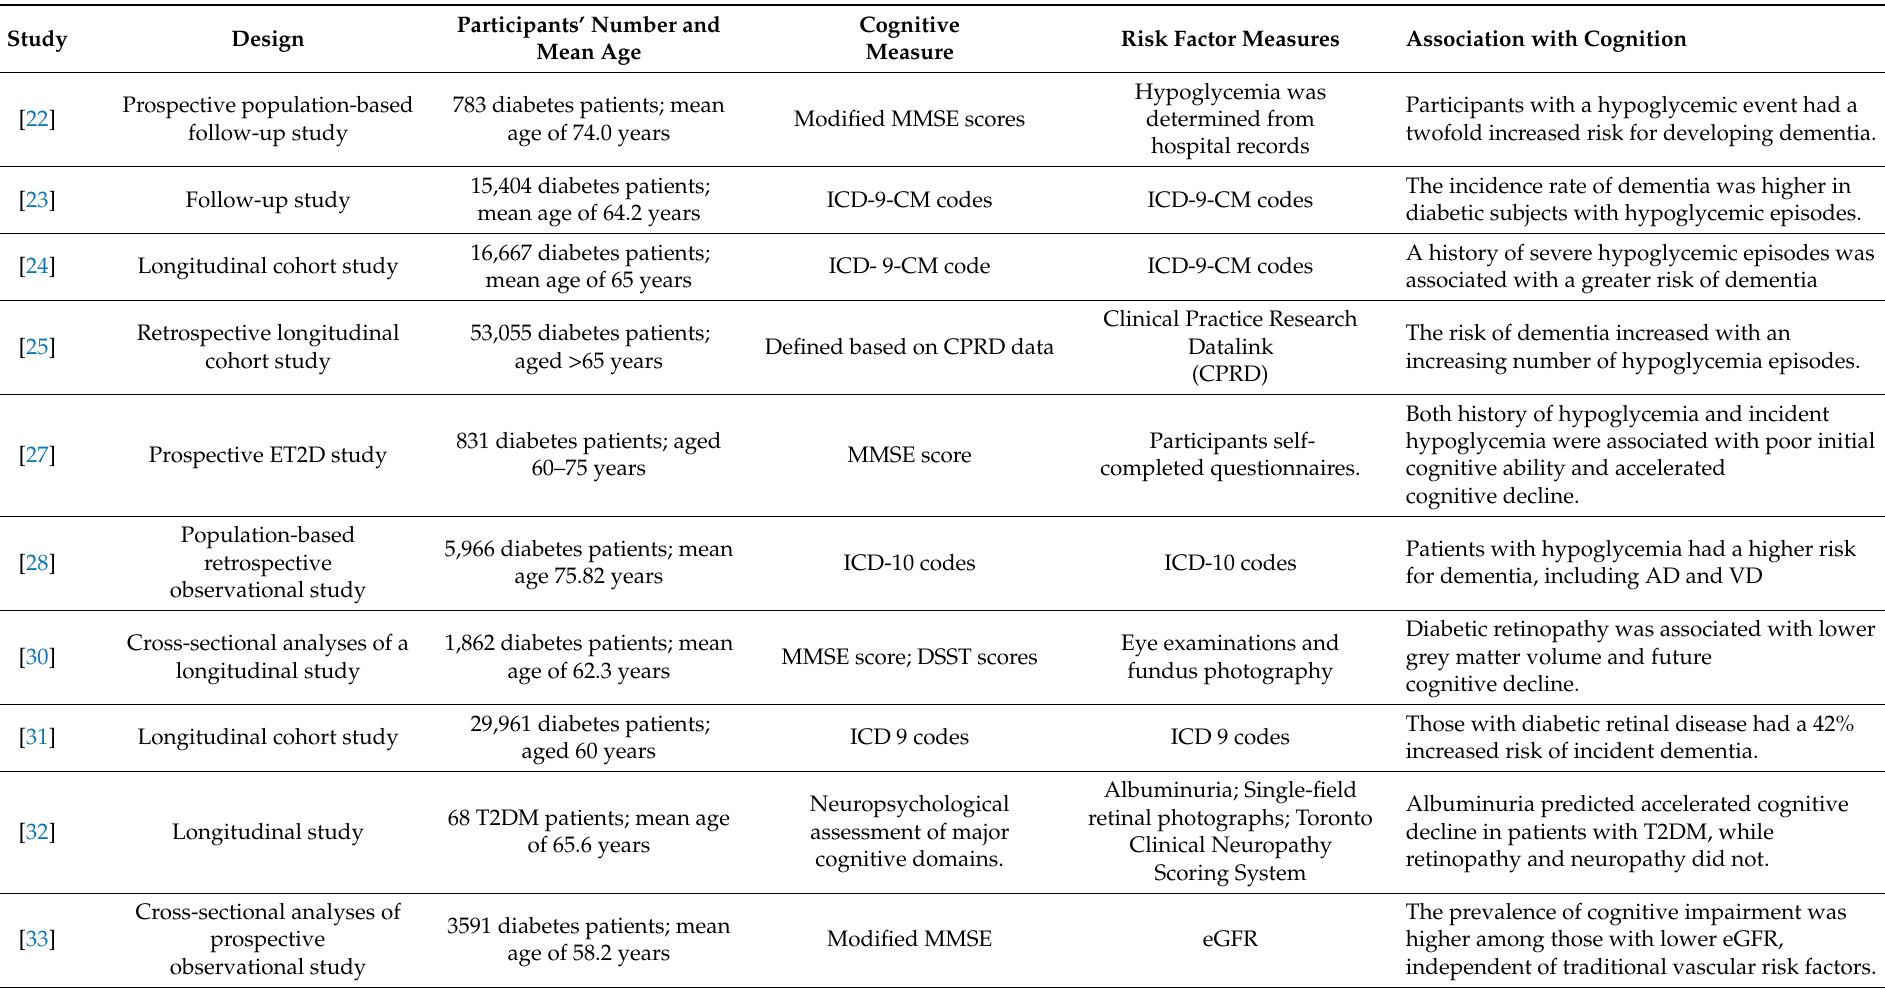
Table 1. Studies showing the associations between type 2 diabetes mellitus complications, cognitive decline, and dementia